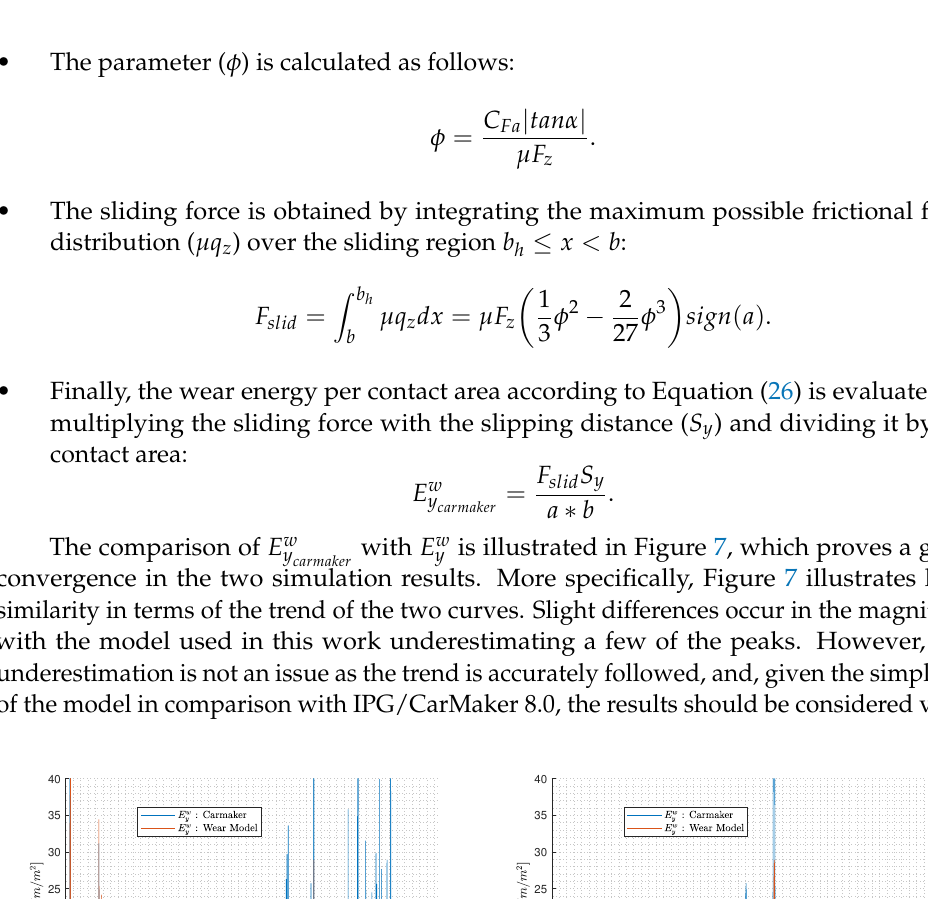
with E w y for: ( a ) the complete simulation time; and ( b ) the time carmaker